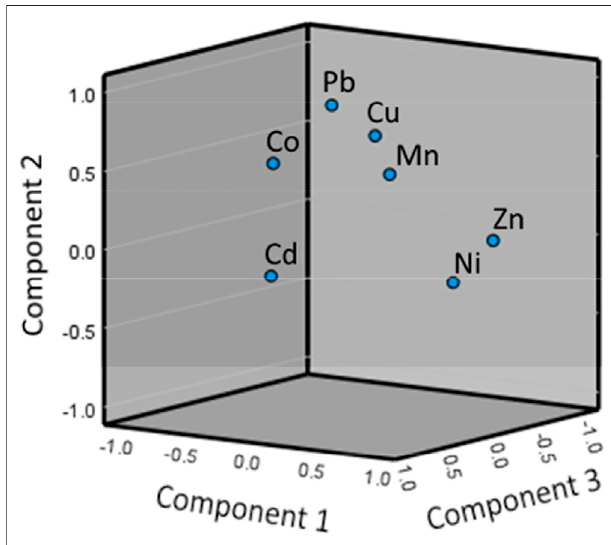
FIGURE3| Thecomponentplotinrotated space forheavymetalsin the study area.